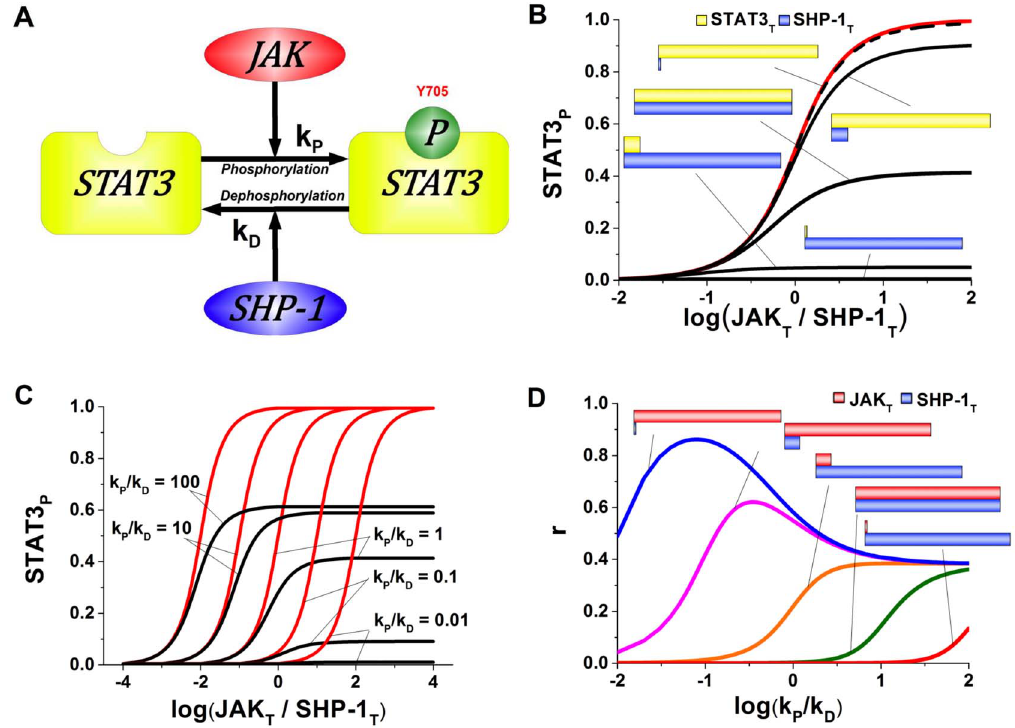
Figure 2. Model predictions for the concentration of STAT3 p phosphorylated by JAK and dephosphorylated by SHP-1. Investigation of the dependence of STAT3 phosphorylation on the relative activities of JAK and SHP. (A) Cartoon diagram of STAT3 phosphorylation and dephosphorylation by JAK and SHP-1, respectively. (B) A comparative analysis of the proposed and applications of the previously published models for STAT3 phosphorylation. Ratios of JAK and SHP-1 are found to be critical for STAT3 phosphorylation response and the differences between the model predictions. The red line shows the predictions by [6] whereas the black line offers predictions from the presented model. The STAT3 phosphorylation predictions coincide when STAT3 significantly exceeds SHP-1 concentration. (C) The effects of phosphorylation and dephosphorylation rates are studied on the proposed (black line) and previously reported (red line) models [6]. We found that our model predicts the modulation of phosphorylated STAT as opposed to the prediction of STAT3 phosphorylation rate offered by [6]. (D) The comparison between the proposed and the previously model [6] is shown as a function of phosphorylation/dephosphorylation rates for various ratios of JAK and SHP-1. This analysis clearly demonstrates the differences in STAT3 phosphorylation predictions due to the underlying assumptions employed in the models.